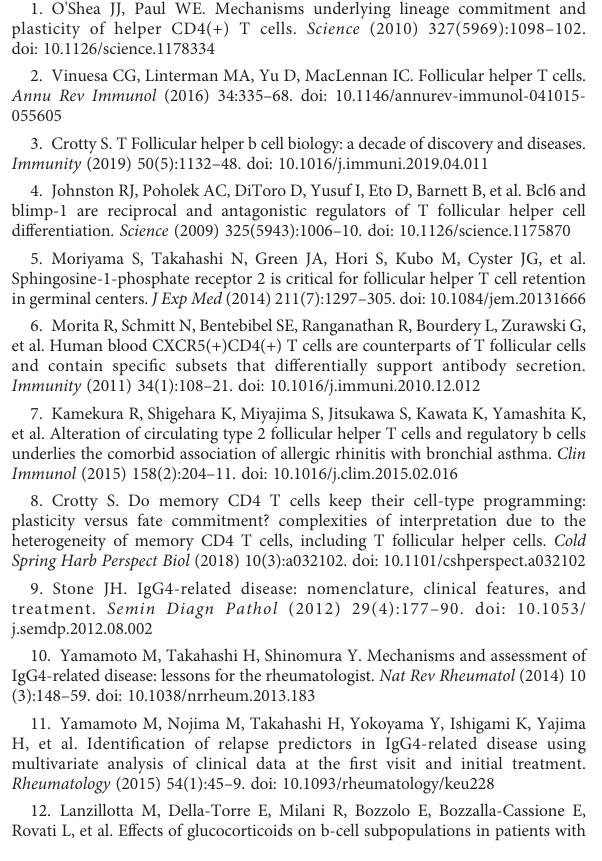
SUPPLEMENTARY TABLE 2 Types of organ involvement in patients with IgG4-RD.